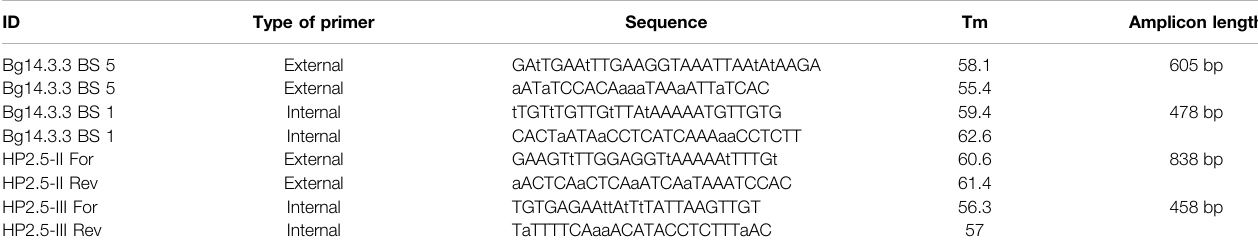
TABLE 4 | Primers designed to check for ef fi ciency of bisul fi te conversion. ID